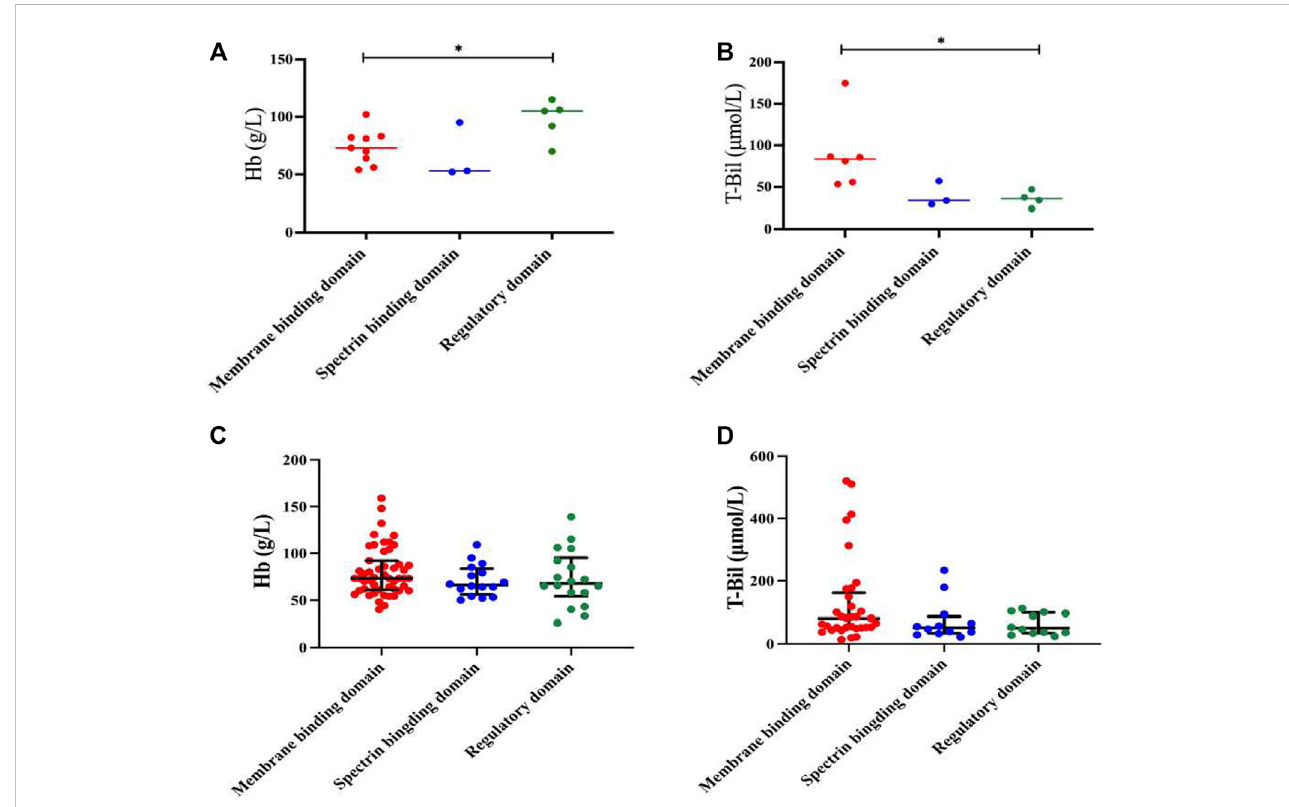
FIGURE 5 Genotype-phenotype correlation in HS patients with mutations of the ANK1. (A,B) Analysis of Hb and T-Bil between mutations of different locations (membrane binding domain, spectrin binding domain and regulatory domain) in 17 HS patients. (C,D) Analysis of Hb and T-Bil between mutations of different locations in all reported Chinese HS patients and our